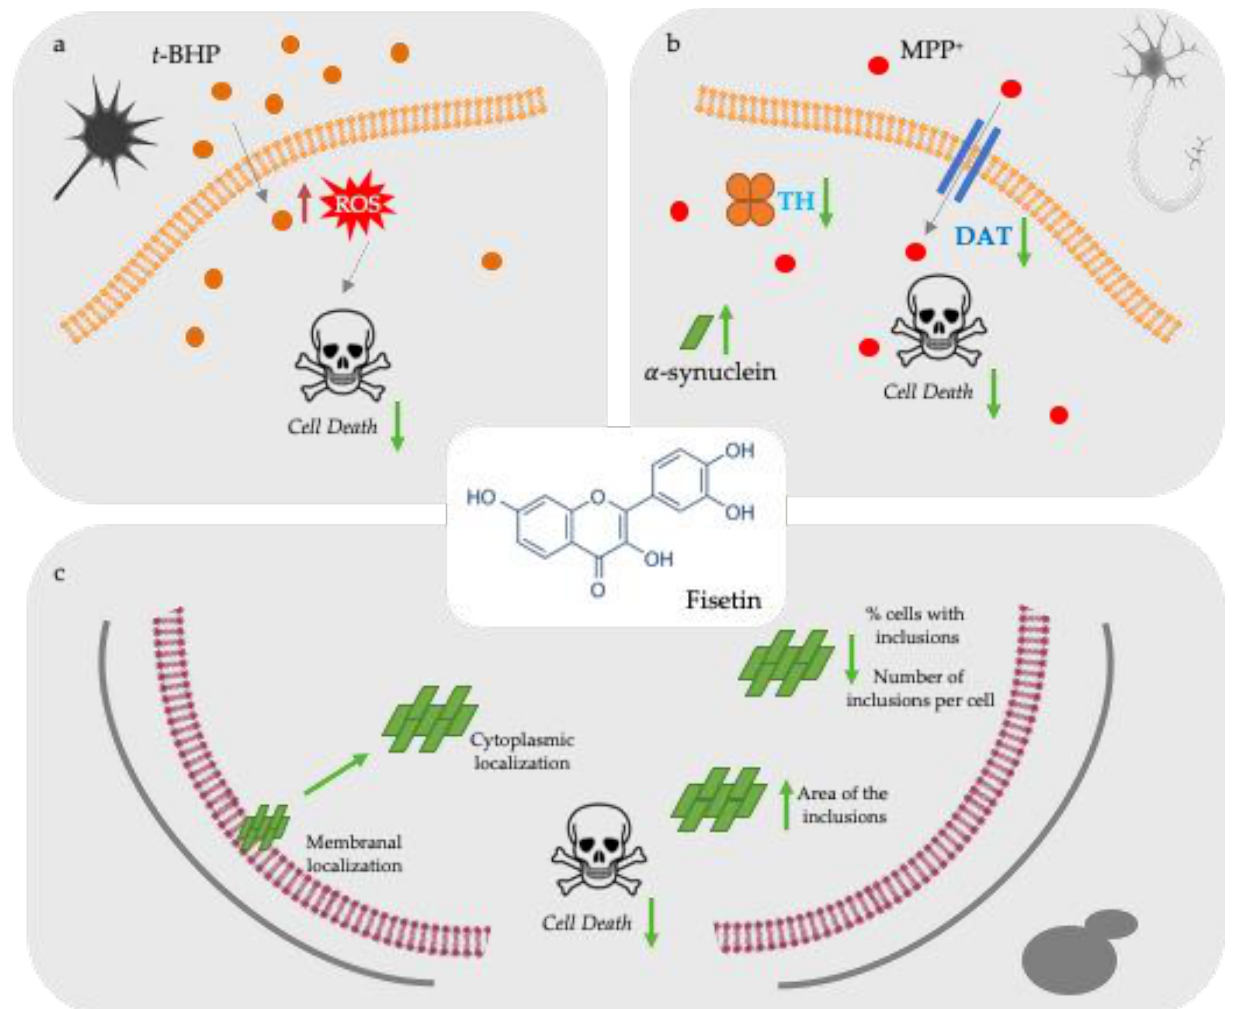
Figure 4. Protective activities of fisetin against PD-associated cellular pathologies. ( a ) Fisetin preincubation reduced oxidative stress-induced cell death in SH-SY-5Y cells caused by t -BHP lesion. ( b ) Fisetin preincubation protects cells from the dopaminergic injury caused by MPP+ with reduction of DAT and TH and an increase of SNCA mRNA expression levels. ( c ) Fisetin modulates human αsyn aggregation in a yeast model of PD. Fisetin reduces αsyn–GFP toxicity in yeast cells by decreasing the number of inclusions per cell, having these inclusions an increased area) and a predominant localization within the cytoplasm. Green arrows indicate fisetin effects in the different models.